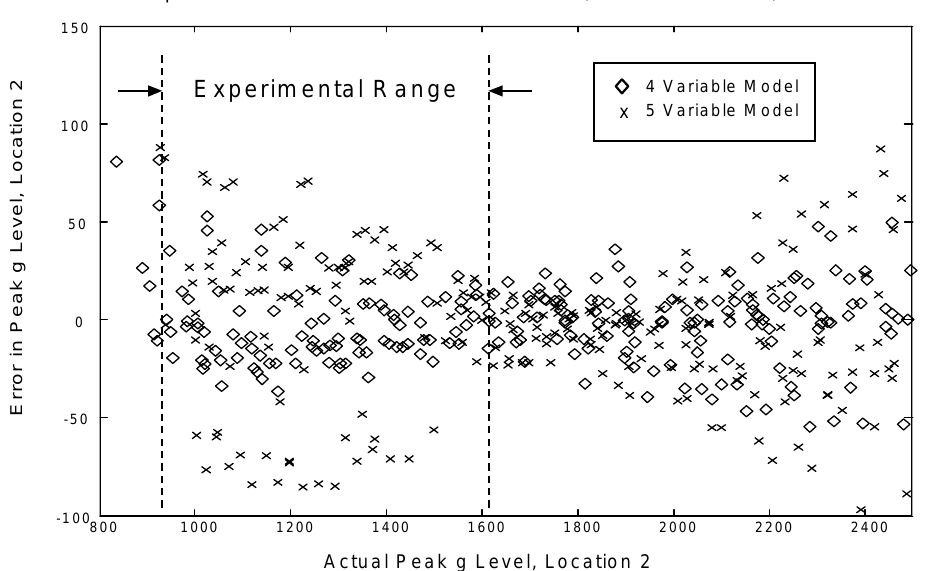
Fig. 9. Error in model prediction of peak G, acclerometer